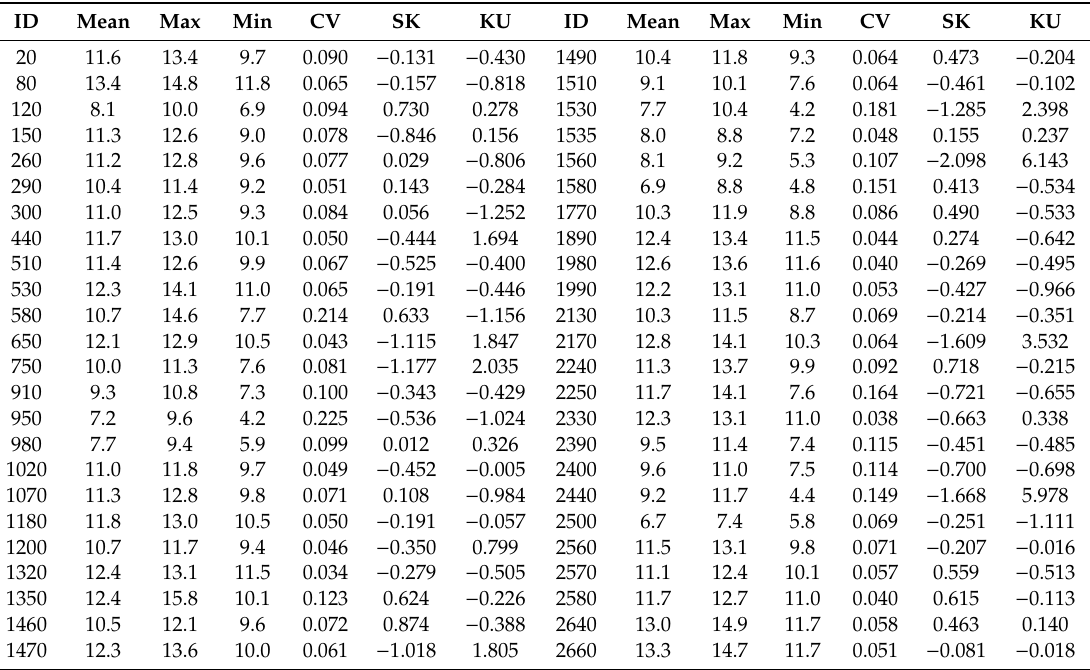
Table 1. Main statistics of the minimum temperature series.